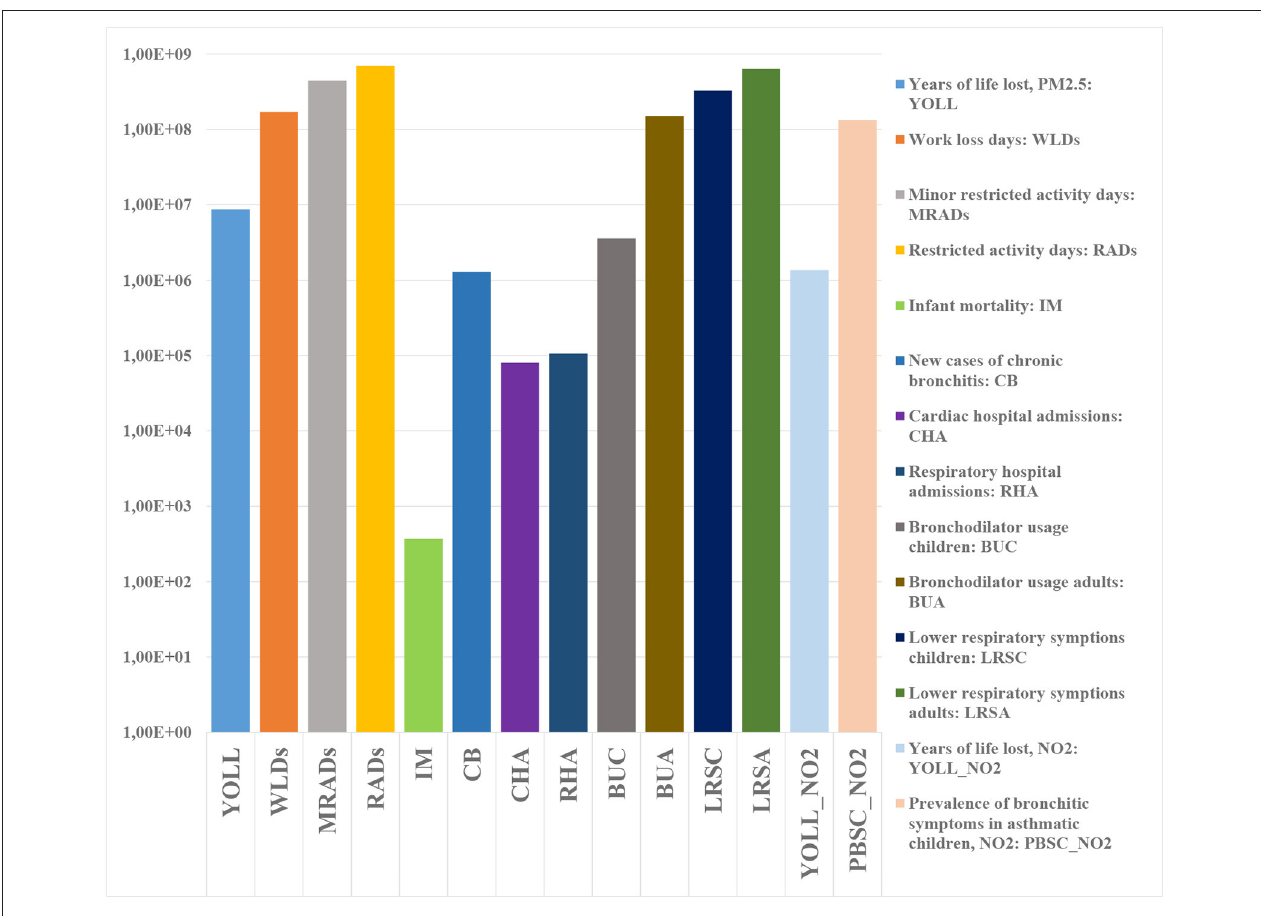
FIGURE 9 | Health impacts for the European population in